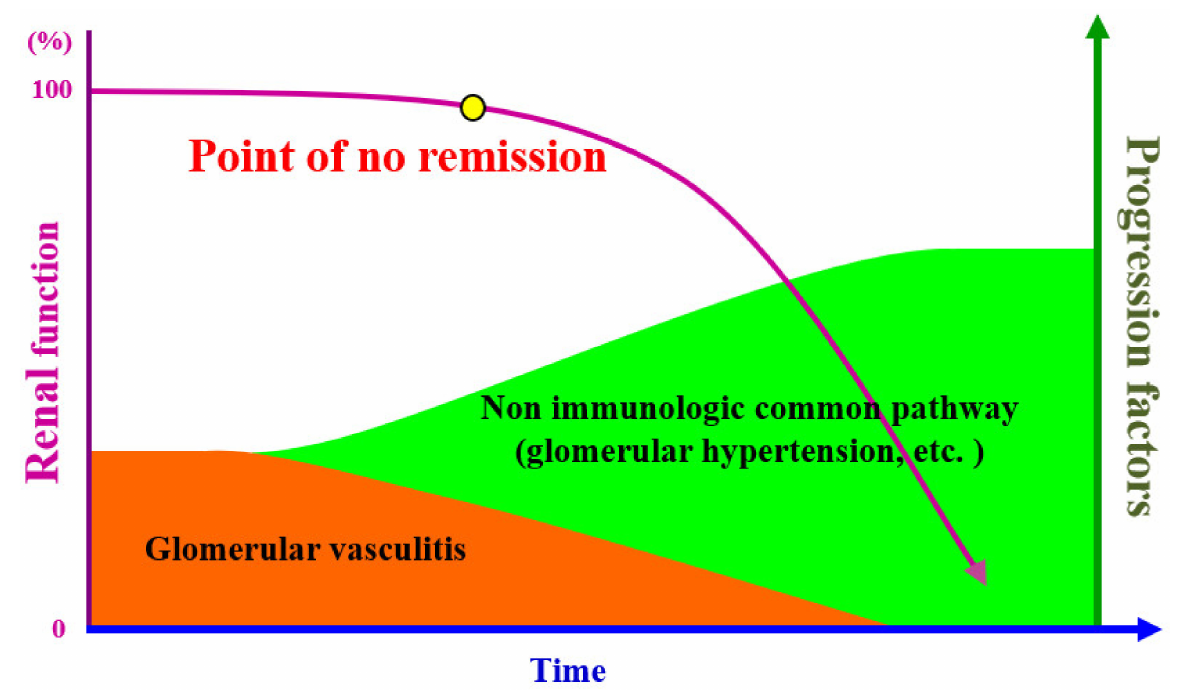
Figure 3. Progression factors in the time course of immunoglobulin A nephropathy (IgAN). Glomerular vasculitis is the main progression factor in the early stages of IgAN. Meanwhile, common pathways, such as glomerular hypertension, ischemia, and proteinuria-related tubulointerstitial injury, are the main contributing progression factors in the later stage of IgAN. Glomerular